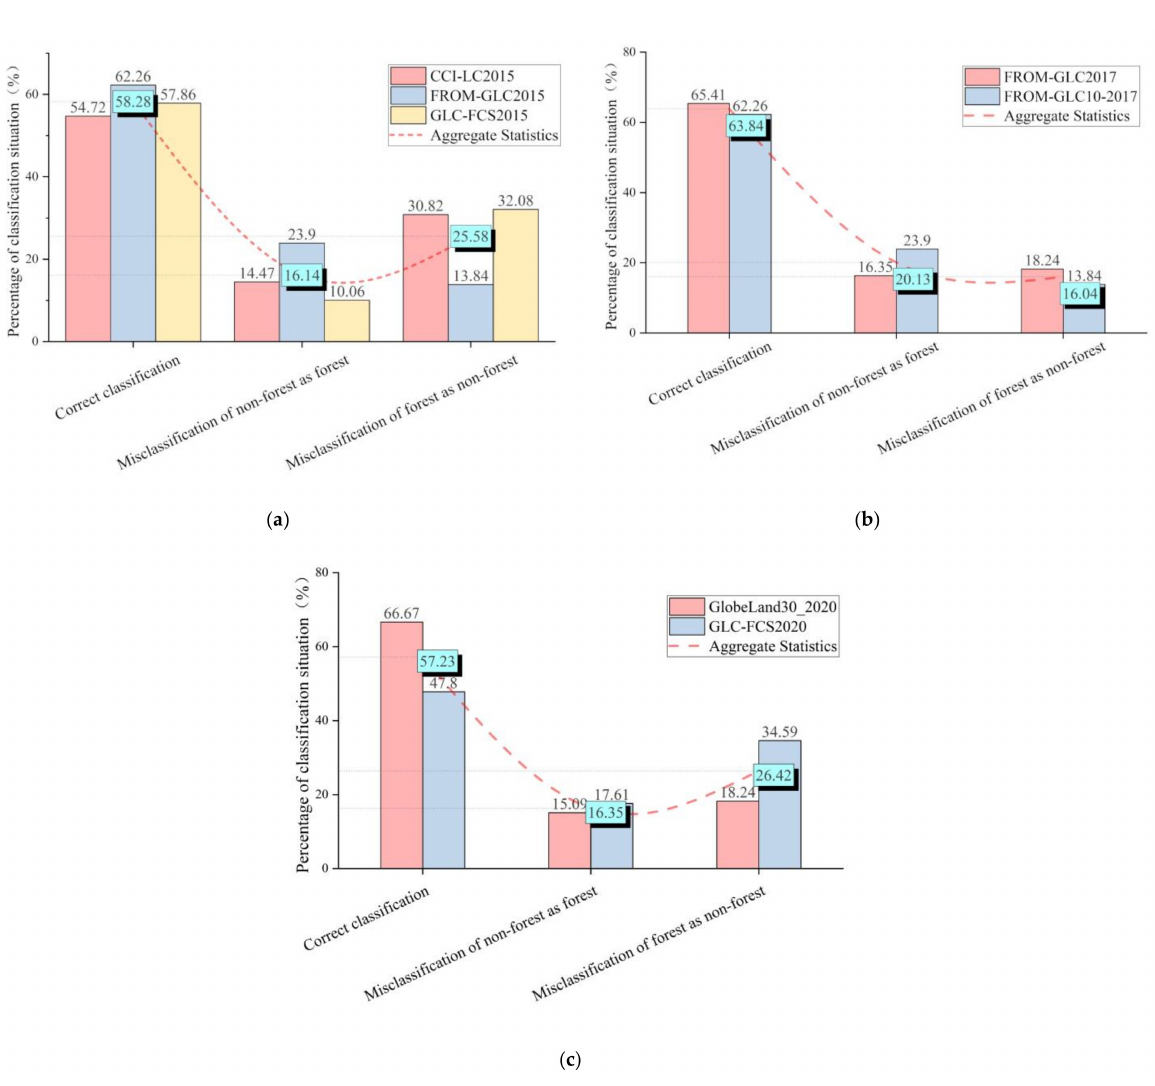
Figure 12. Proportion of forest datasets correctly classified and two incorrectly classified in 2015/2017/2020. ( a ) Three datasets in 2015; ( b ) Two datasets in 2017; ( c ) Two datasets in